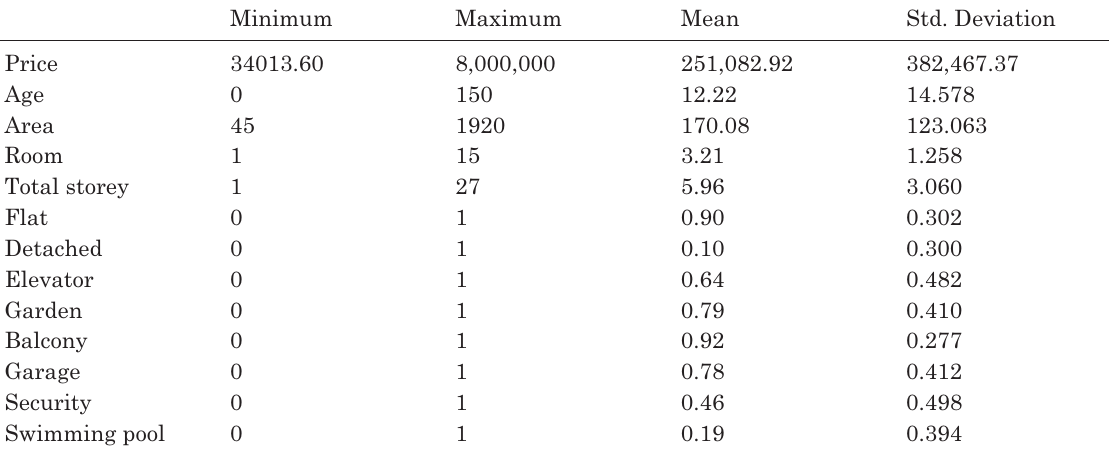
Table 1. Descriptive statistics of housing units for Istanbul transaction data N: